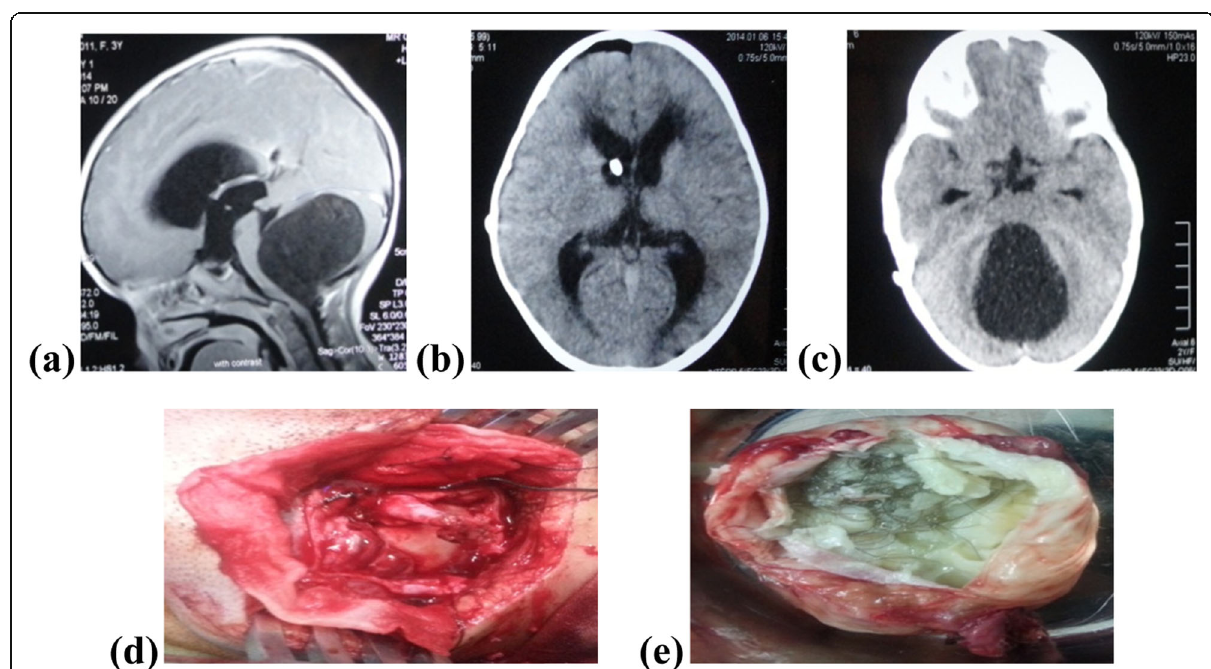
Fig. 5 a – e Female patient 3 years old of dermoid cyst (congenital benign tumour). a Preoperative T1-weighted MRI brain sagittal view with